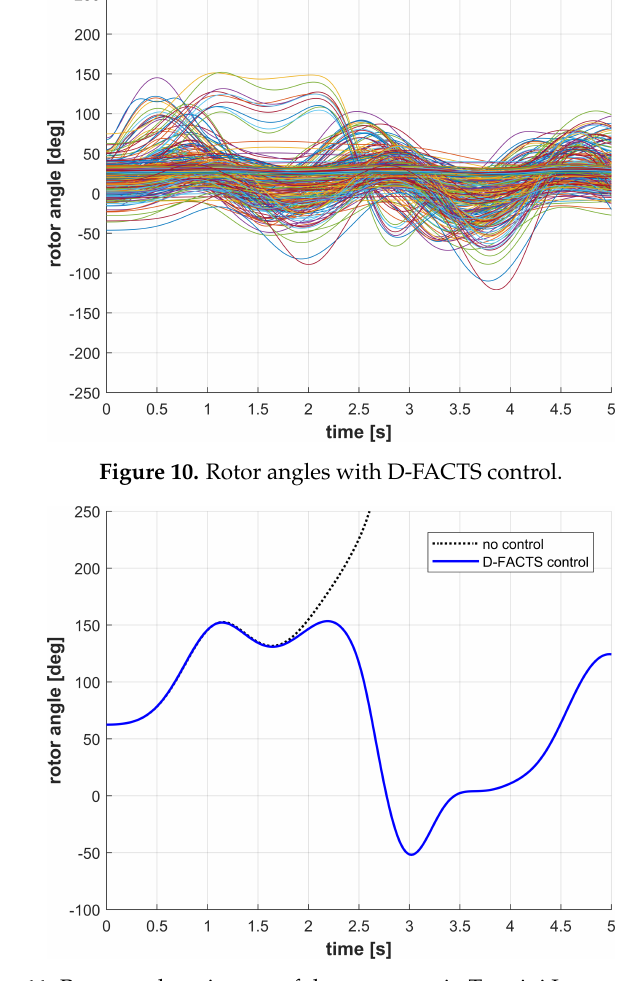
Figure 11. Rotor angle trajectory of the generator in Termini Imerese (Sicily).